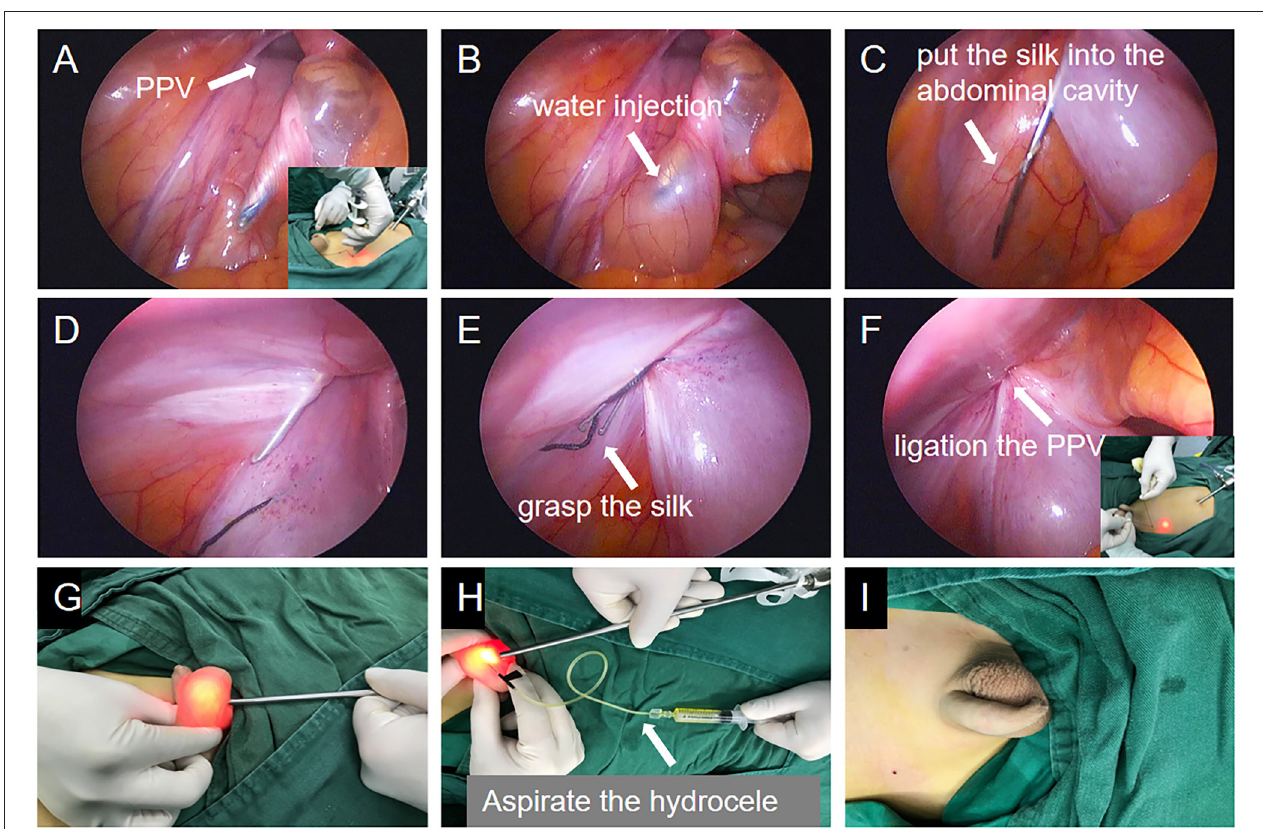
FIGURE 2 | The images of single-port laparoscopic percutaneous extraperitoneal closure operation steps with the abdominal wall suture device with water injection function. (A) Crochet with thread was inserted into the lateral inferior epigastric artery. (B) The hook needle with thread in the extraperitoneal space sneaked along the inner side of the processus vaginalis to the vas deferens. The inclined plane of the crochet deviated from the operator’s field of vision, against the vas deferens, and injected normal saline to jack up the retroperitoneum and cross the space between the vas deferens and the retroperitoneum. (C) After crossing the spermatic vessels, the peritoneum was punctured and the silk thread was placed in the abdominal cavity. (D) The crochet needle sneaked along the outer side of the inner ring in the extraperitoneal space. (E) Hook the silk thread in the abdominal cavity. (F) Knot in the extraperitoneal space and close the processus vaginalis. (G) Laparoscopic lens is helpful to identify hydrocele. (H) The liquid in the tunica vaginalis was aspirated by syringe. (I) The photograph of the scrotum after the operation.